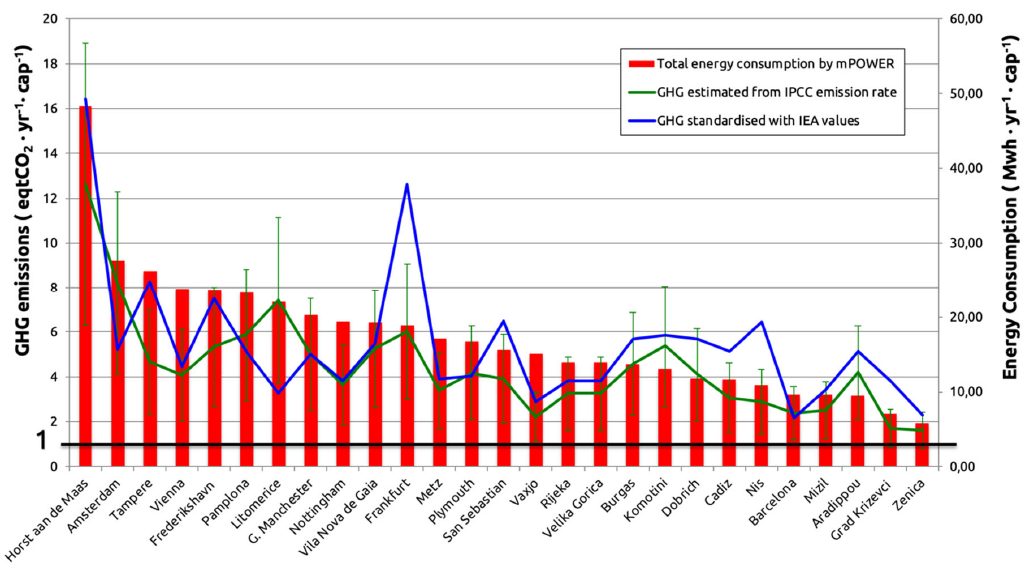
Figure 7. Energy consumption per capita by municipality, and the respective greenhouse gas (GHG) emissions obtained from the survey (IEA standardised) and calculated from the energy consumption and the IPCC emission intensities.